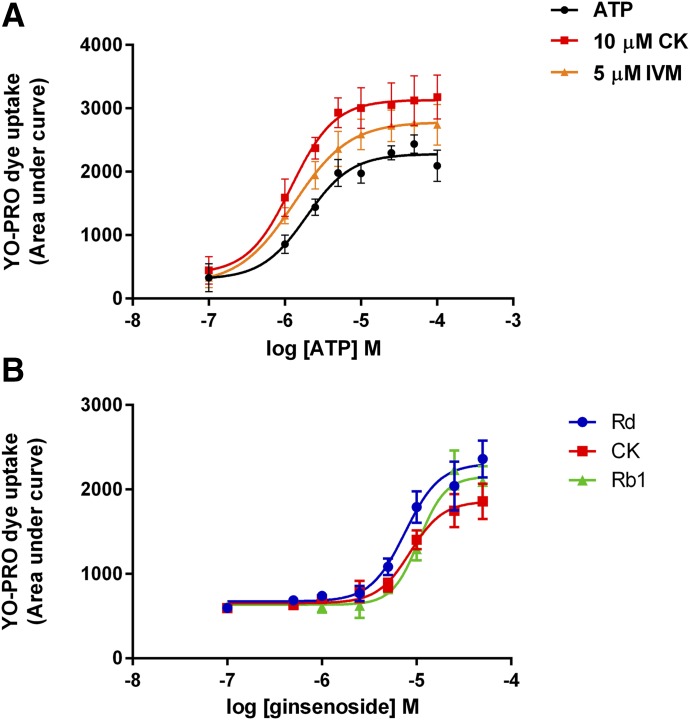
Ginsenosides enhance ATP responses at recombinant hP2X4. (A) Various concentrations of ATP (100 nM to 100 µM) were used to activate hP2X4, and YOPRO-1 uptake over 200 seconds was measured on a Flexstation 3. Concentration response to ATP is shown in black, ATP in the presence of 10 µM CK is shown in red, and ATP in the presence of ivermectin (IVM; 5 µM) is shown in orange. Data are taken from three independent experiments, and error bars represent S.E.M. Transformed data were curve fit using nonlinear regression, and EC50 values were 1.92 µM ATP, 1.22 µM for ATP + CK, and 1.3 µM for ATP + IVM. (B) Concentration response relationship for select ginsenosides on YOPRO-1 dye uptake to 5 µM ATP in HEK-hP2X4 cells. Ginsenosides were tested over the range 0.1–50 µM. EC50 values were 7.5 µM Rd, 8.5 µM CK, and 10.5 µM Rb1. Data were taken from three independent experiments.